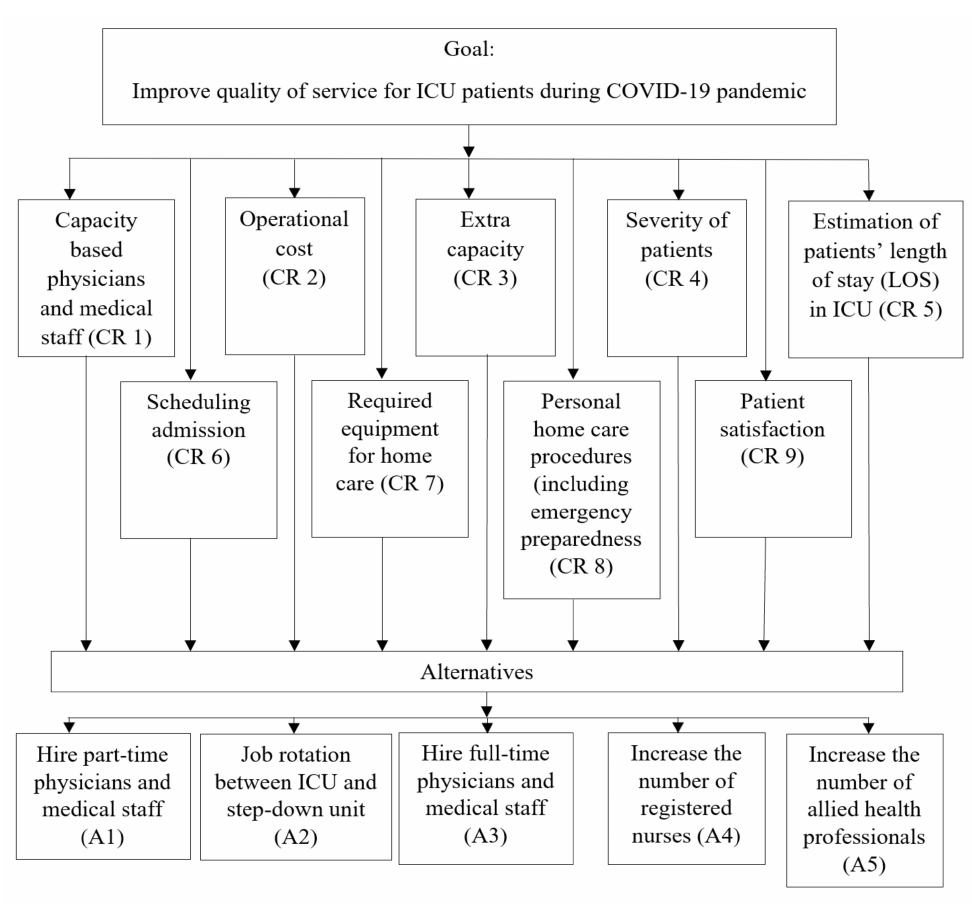
Figure 1. Schematic flowchart of selected criteria and